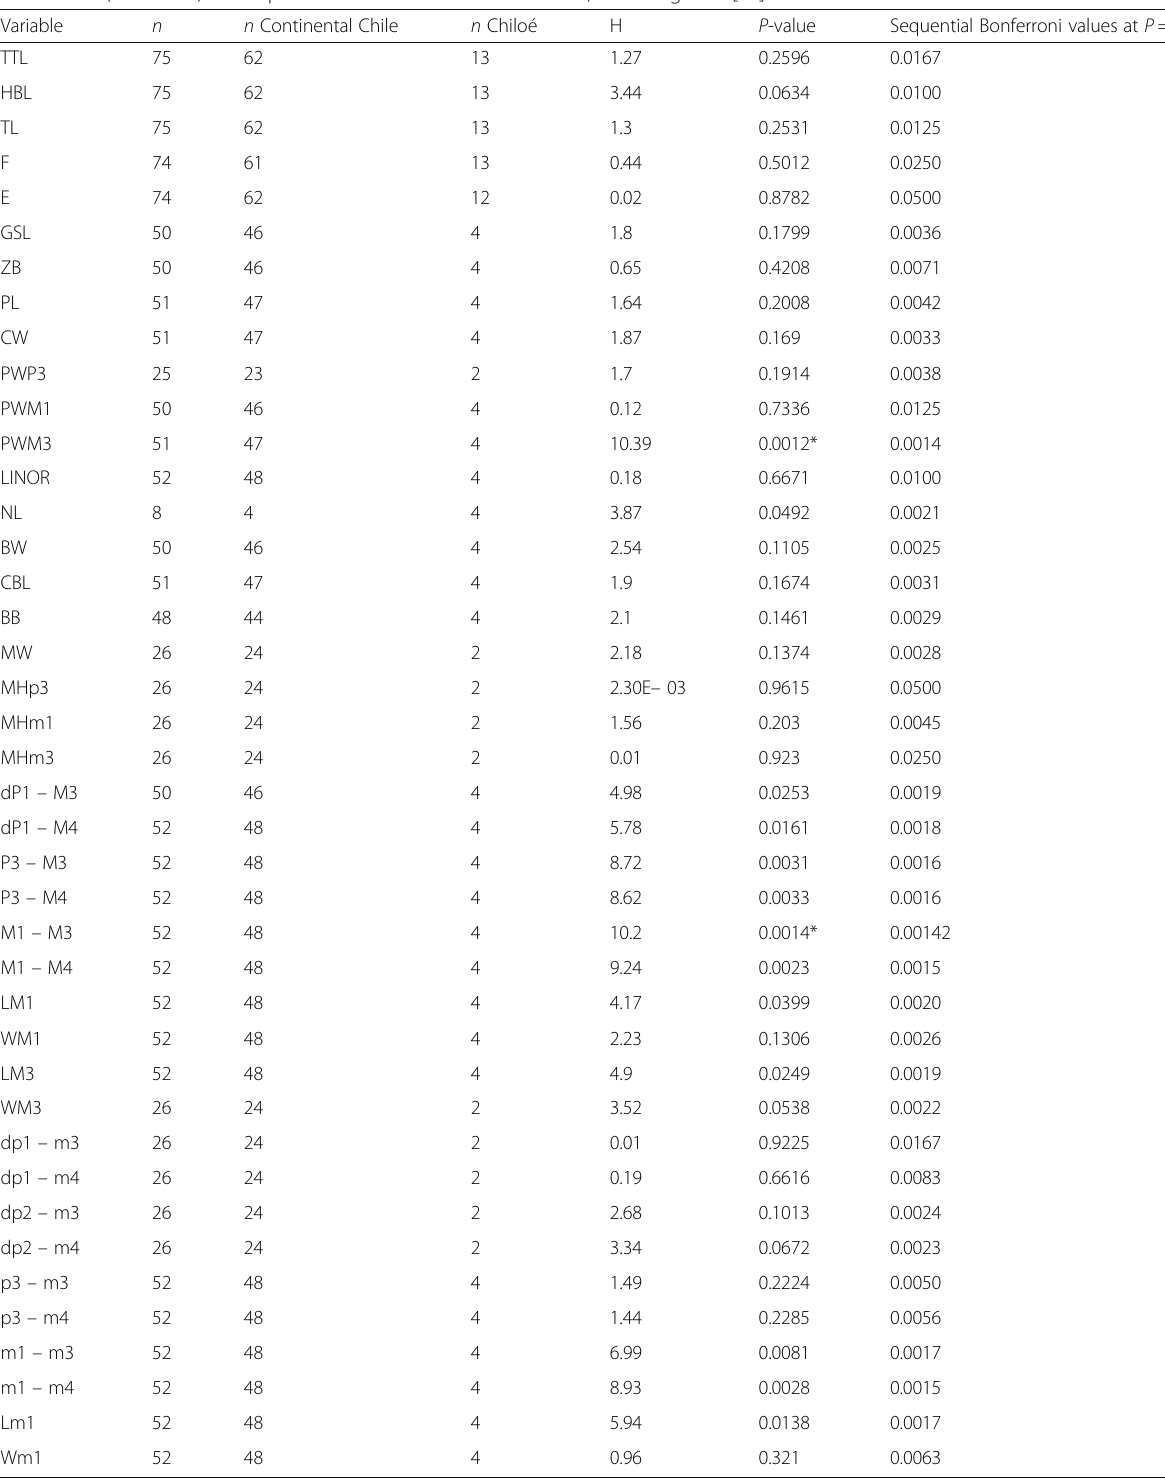
Table 5 Results of a non – parametric Kruskal – Wallis analysis of variance (ANOVA), calculated from Mosimann ’ s variables for differences between continental and Chiloé Island samples of Rhyncholestes raphaunurus Osgood. Total number of specimens ( n ), and number of specimens for continental Chile and Chiloé Island are indicated for each measurement. Asterisks mark significant differences (if existent) for sequential Bonferroni-corrected values, following Rice [39]. See text for variable